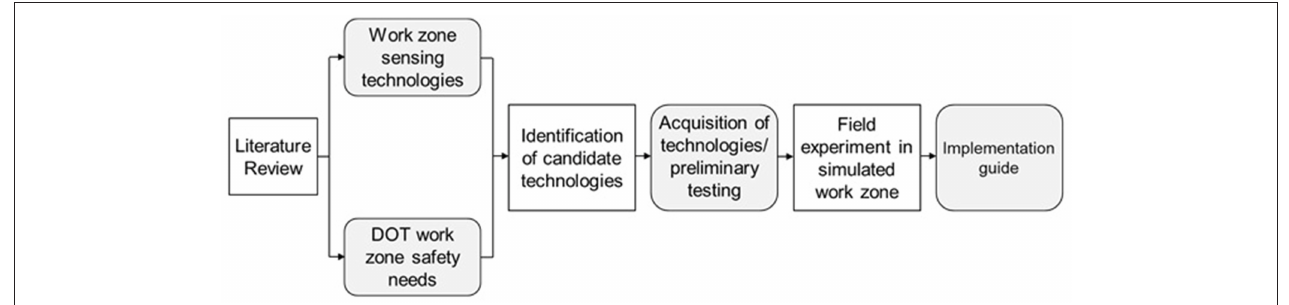
FIGURE 1 | Research methodology framework.